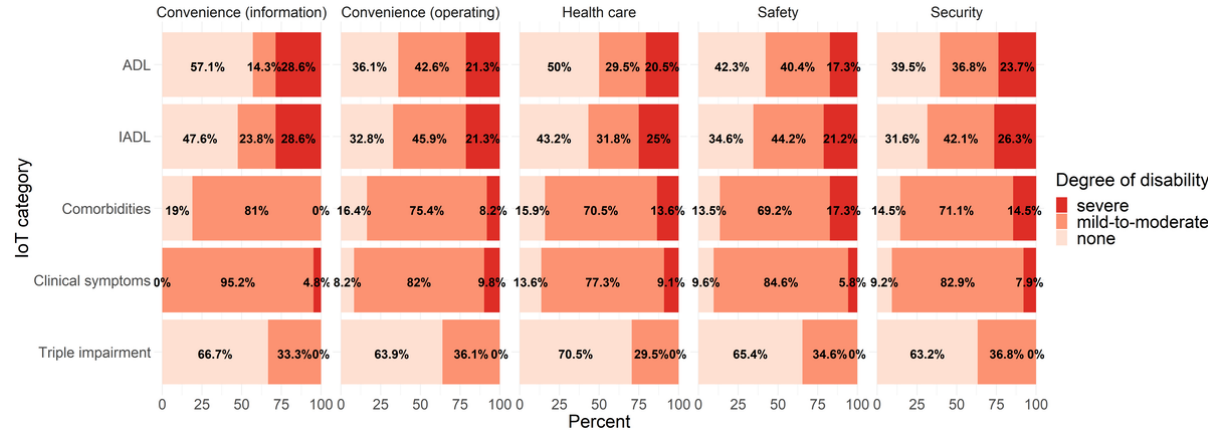
Figure 2. The total number of Internet of Things (IoT) needs by category, as a function of underlying conditions in disabled people. ADL: activities of daily living; IADL: instrumental activities of daily living; Triple impairment: hearing, vision, and speech